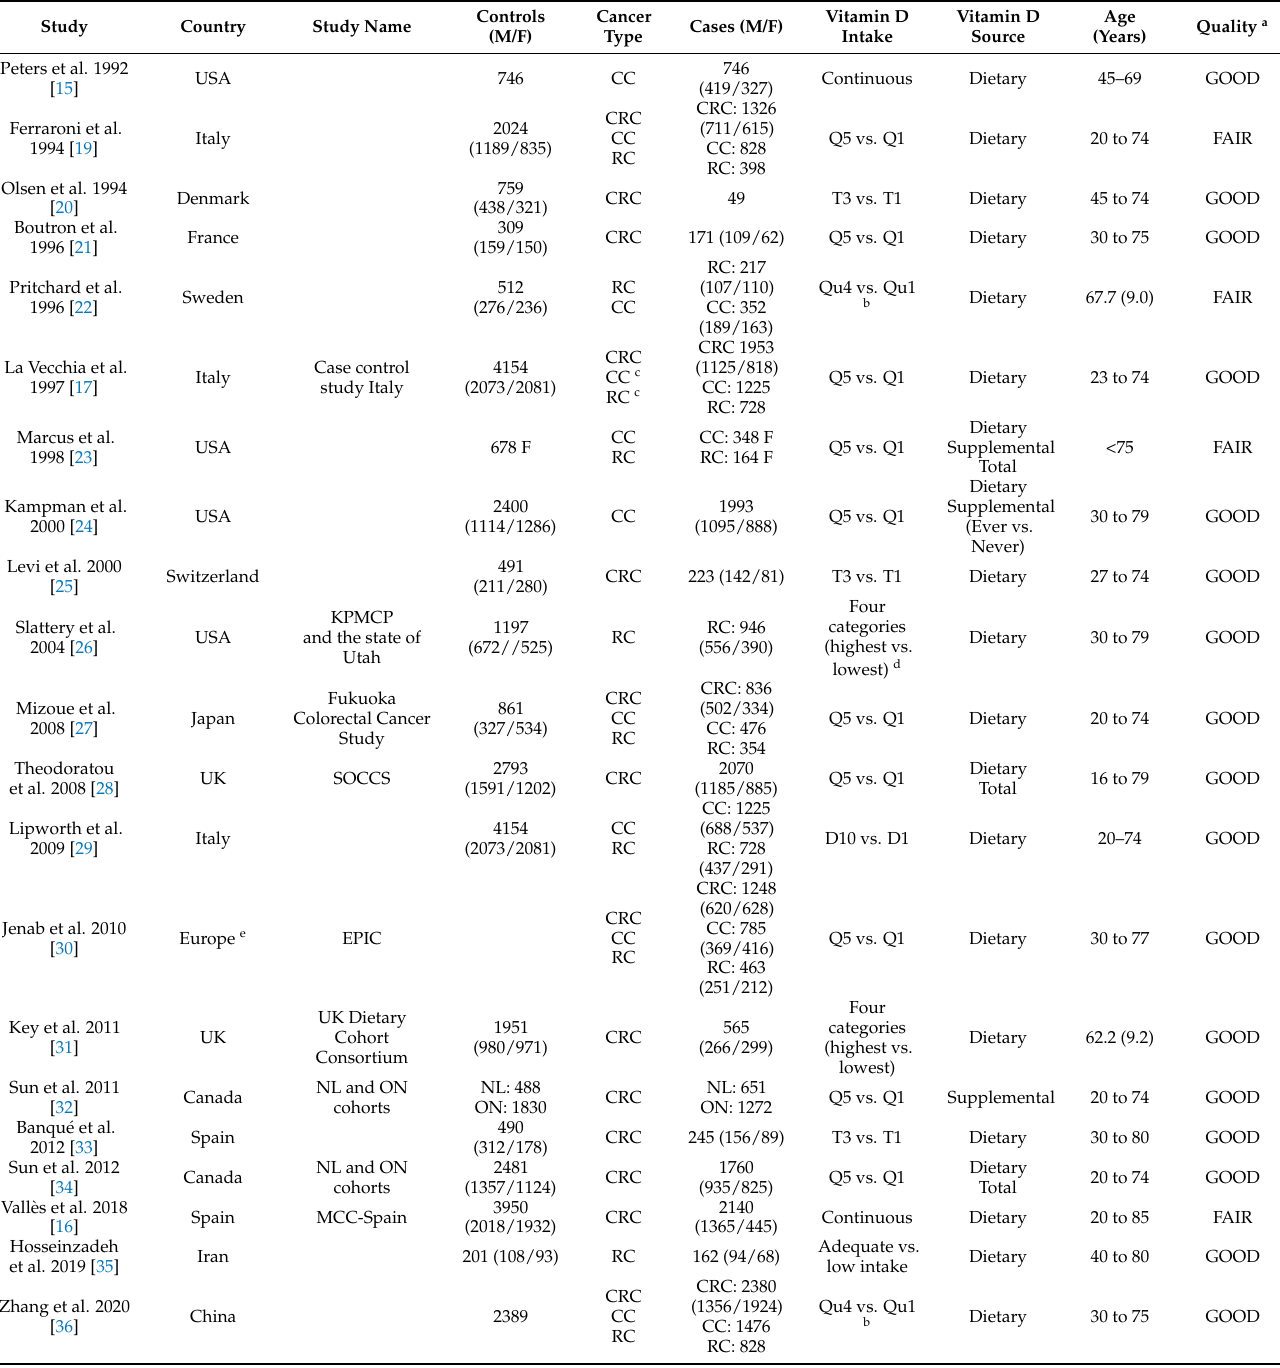
Table 1. Characteristics of case-control studies included in the systematic review and meta-analysis